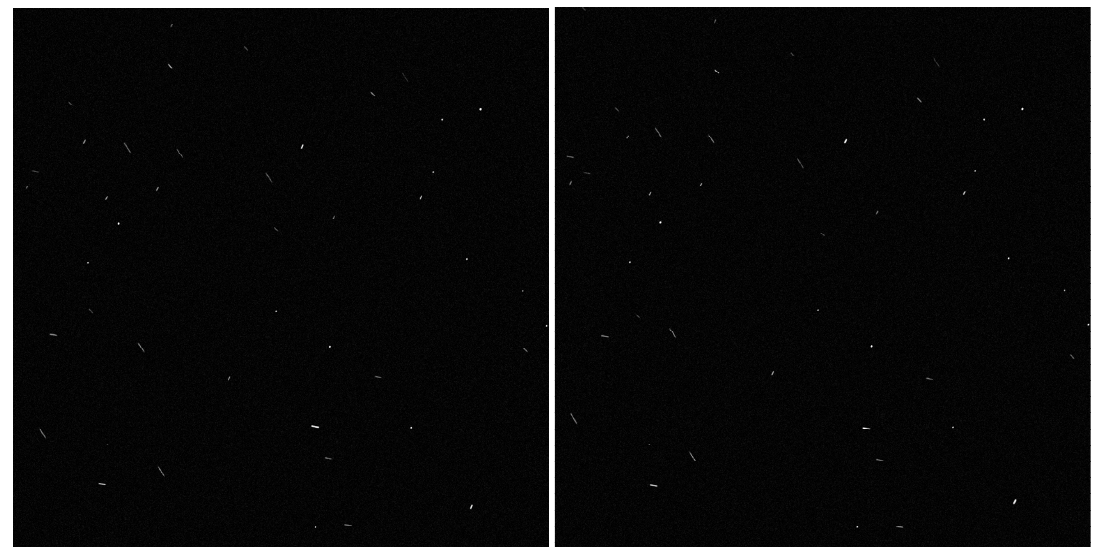
Figure 9. Generated actual plume star image.